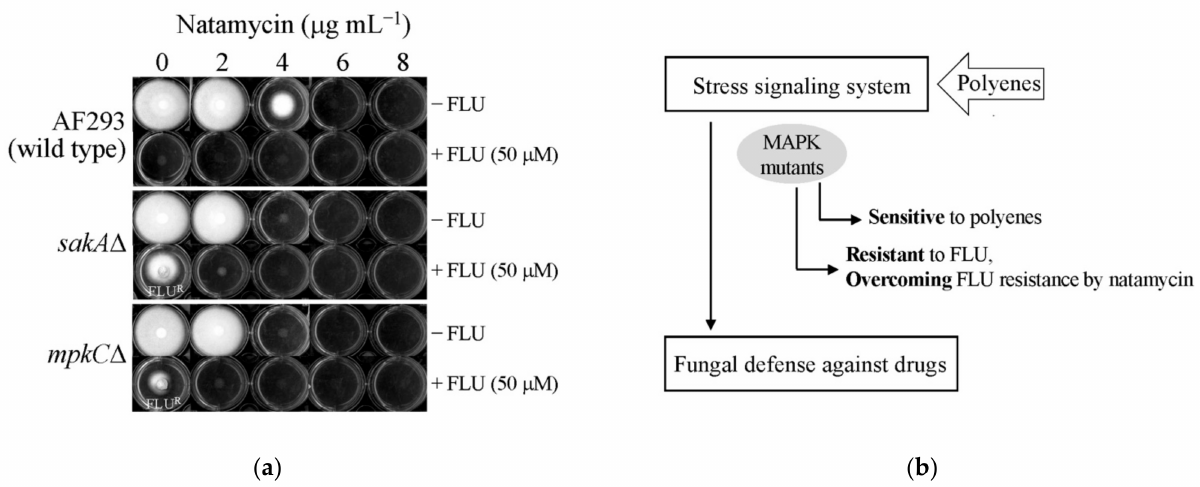
Figure 2. ( a ) The level of fungal growth without or with the treatment of natamycin (NAT) (2, 4, 6, 8 µ g mL − 1 ) and/or fludioxonil (FLU) (50 µ M) tested in A. fumigatus AF293 (wild type) and MAPK mutants ( sakA ∆ , mpkC ∆ ); ( b ) diagram: overcoming FLU tolerance of A. fumigatus MAPK mutants by combined application of